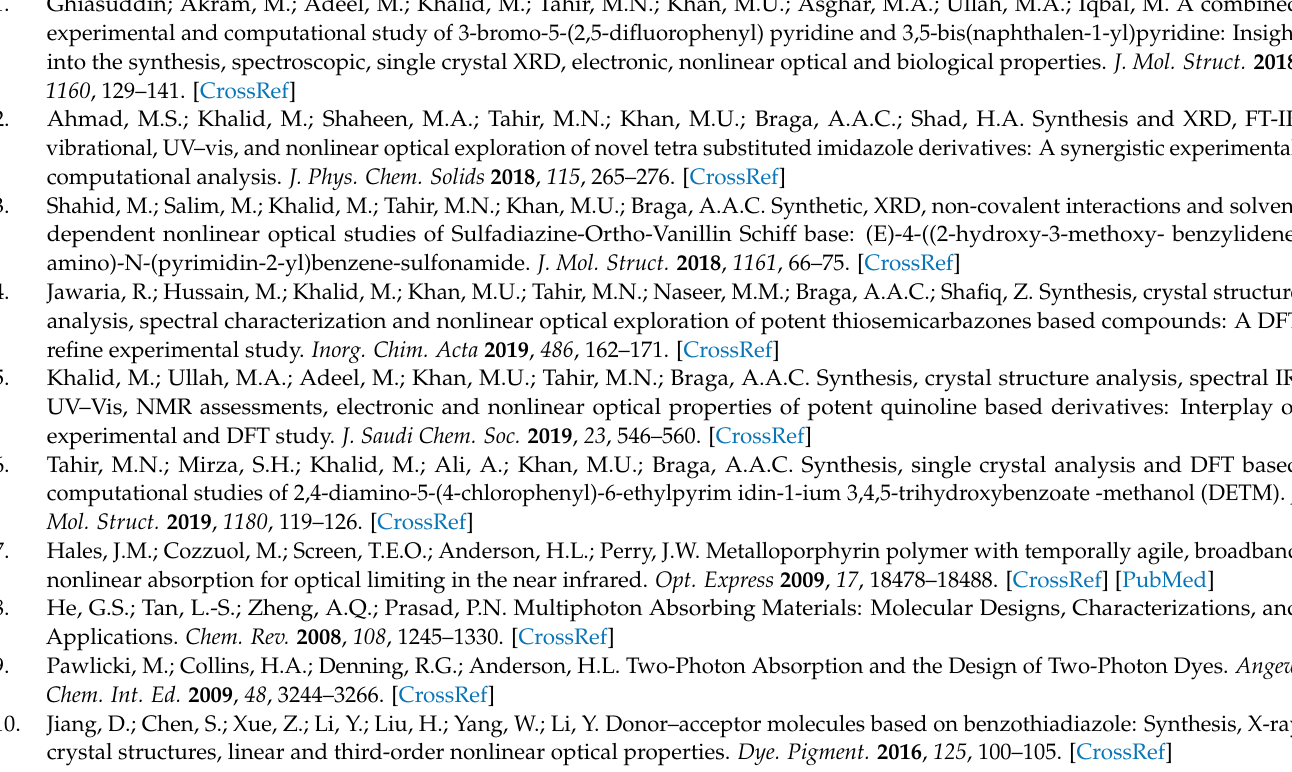
of of investigated compound Q4 ; Figure S3: Graph of of investigated compound Q5 . Figure S4: Graph of investigated compound Q3D1 ; Figure S5:Graph of investigated compound Q3D2 ; Figure S6: Graph of investigated compound Q3D3 ; Figure S7: Graph of investigated compound Q4D1 ; Figure S8:Graph of investigated compound Q4D2 ; Figure S9: Graph of investigated compound Q5D1